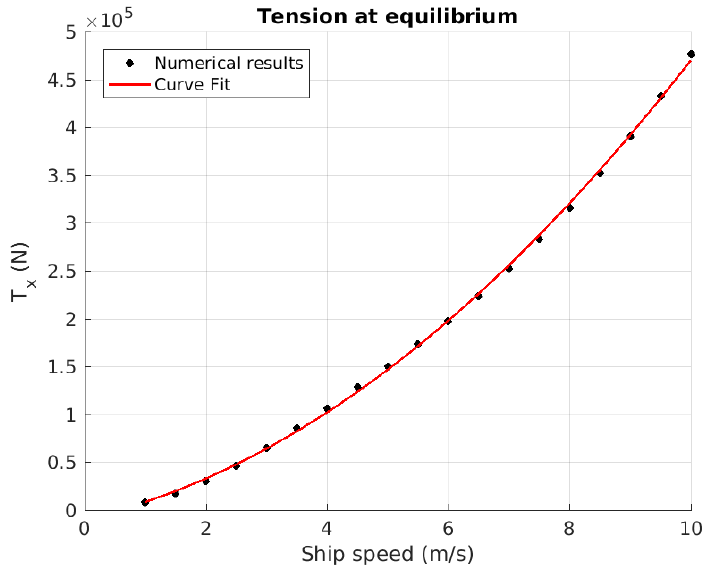
( a ) Cable shapes at equilibrium (t=150s). ( b ) Time evolution of the vertical coordinate the towed body. Figure 20. Submerged towed bodies towed at three different speeds.